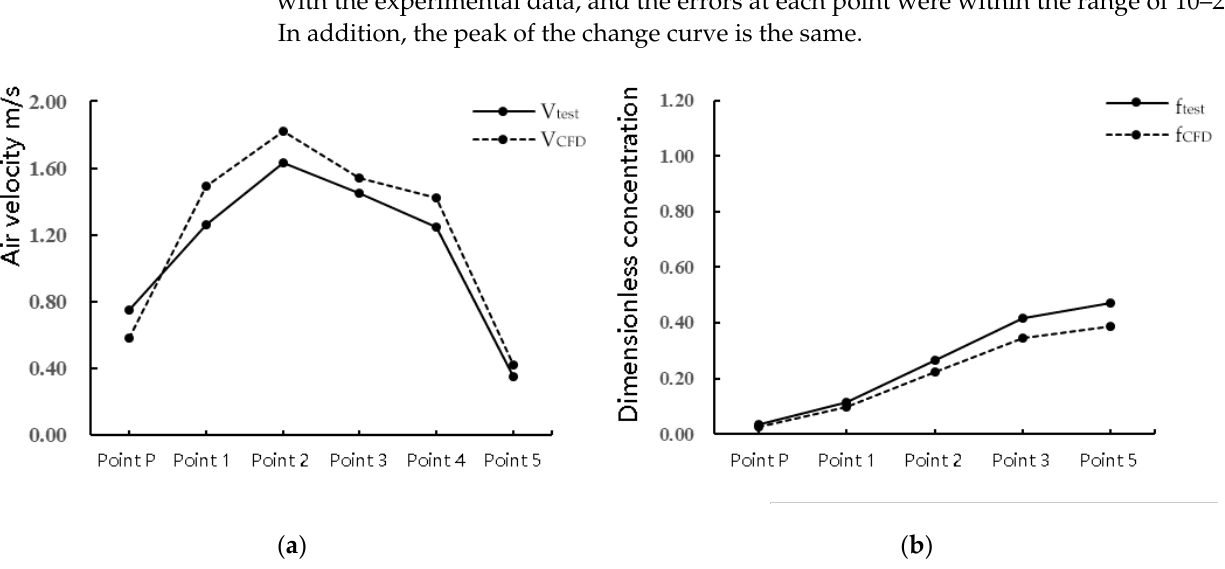
Table 5. Measured values and simulation results of each measurement point.